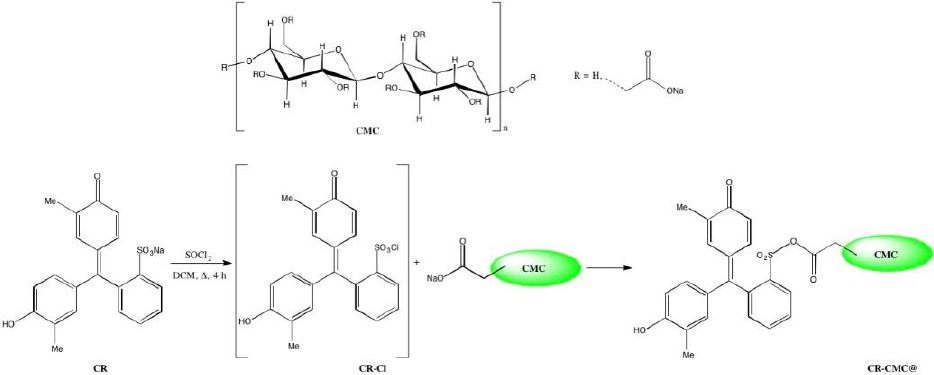
Figure 1. Reaction scheme for covalent anchoring of o -cresol red to CMC.